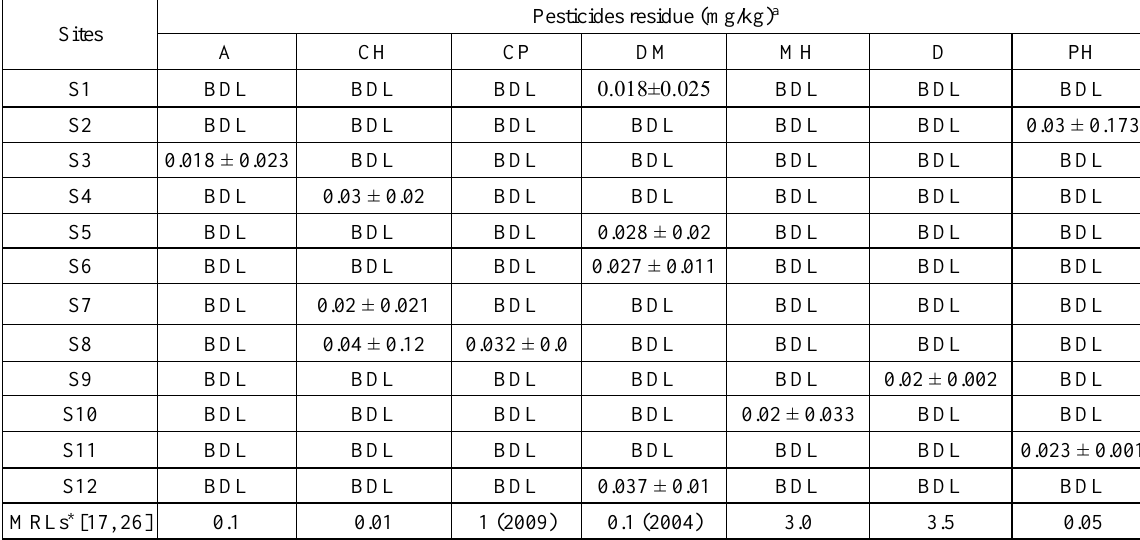
Table 3. Concentration of pesticides residues in cauliflower Sites